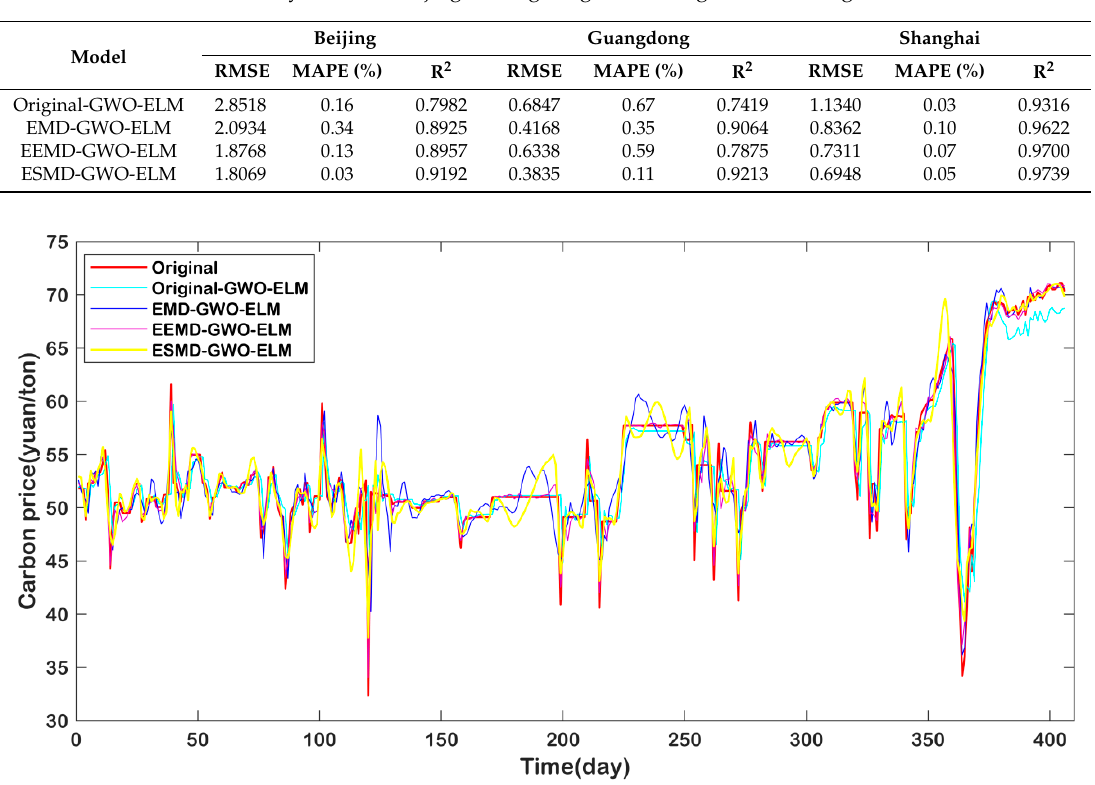
Figure 15. The results of Beijing carbon price forecasting.